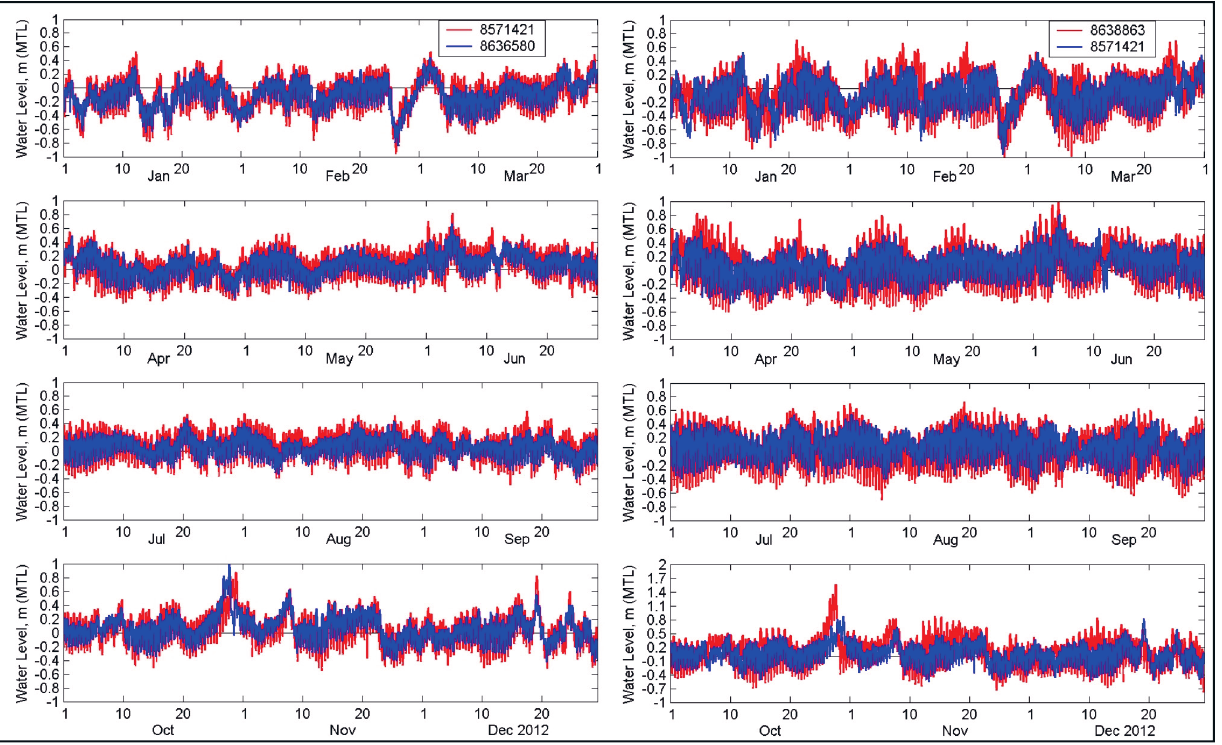
Figure 10. Water levels at Bishops Head (Station 8571421), Windmill Point (8636580), and Bay Bridge Tunnel (8638863) for